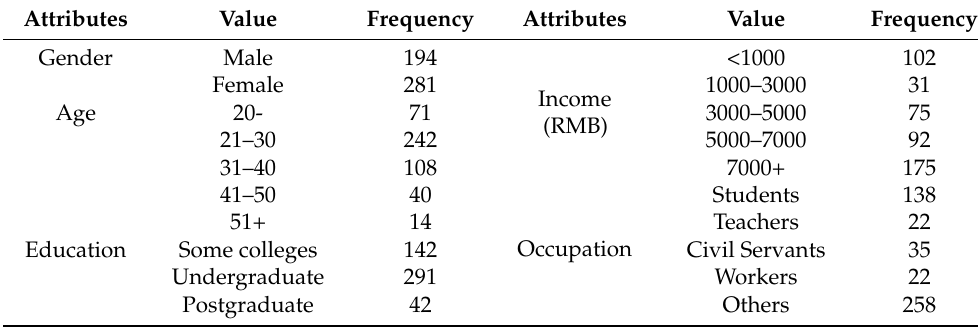
Table 2. Demographic information and attitude for home motion sensing